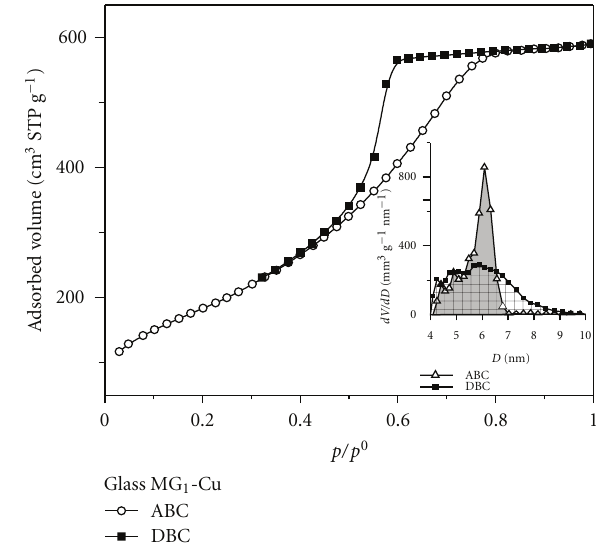
Figure 5: Raman scattering spectra of MG 3 , MG 3 -Cu, and MG 3 -Fe.